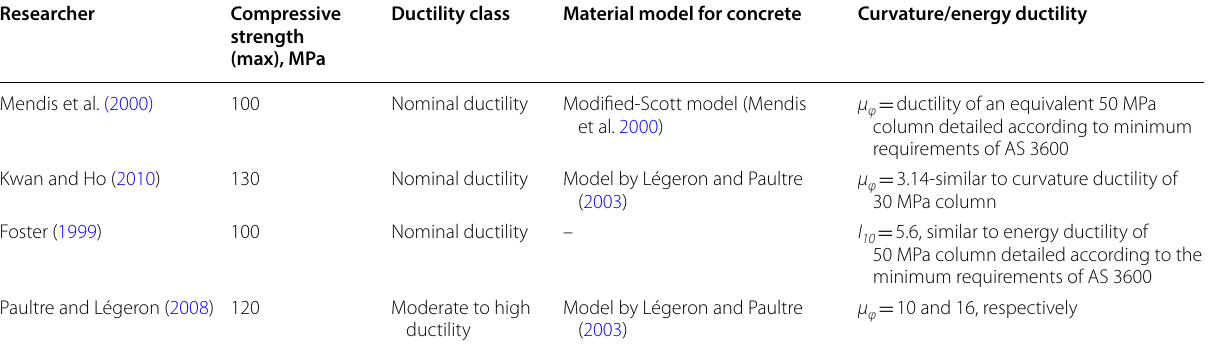
Table 1 Summary of ductile design guidelines for HSC and